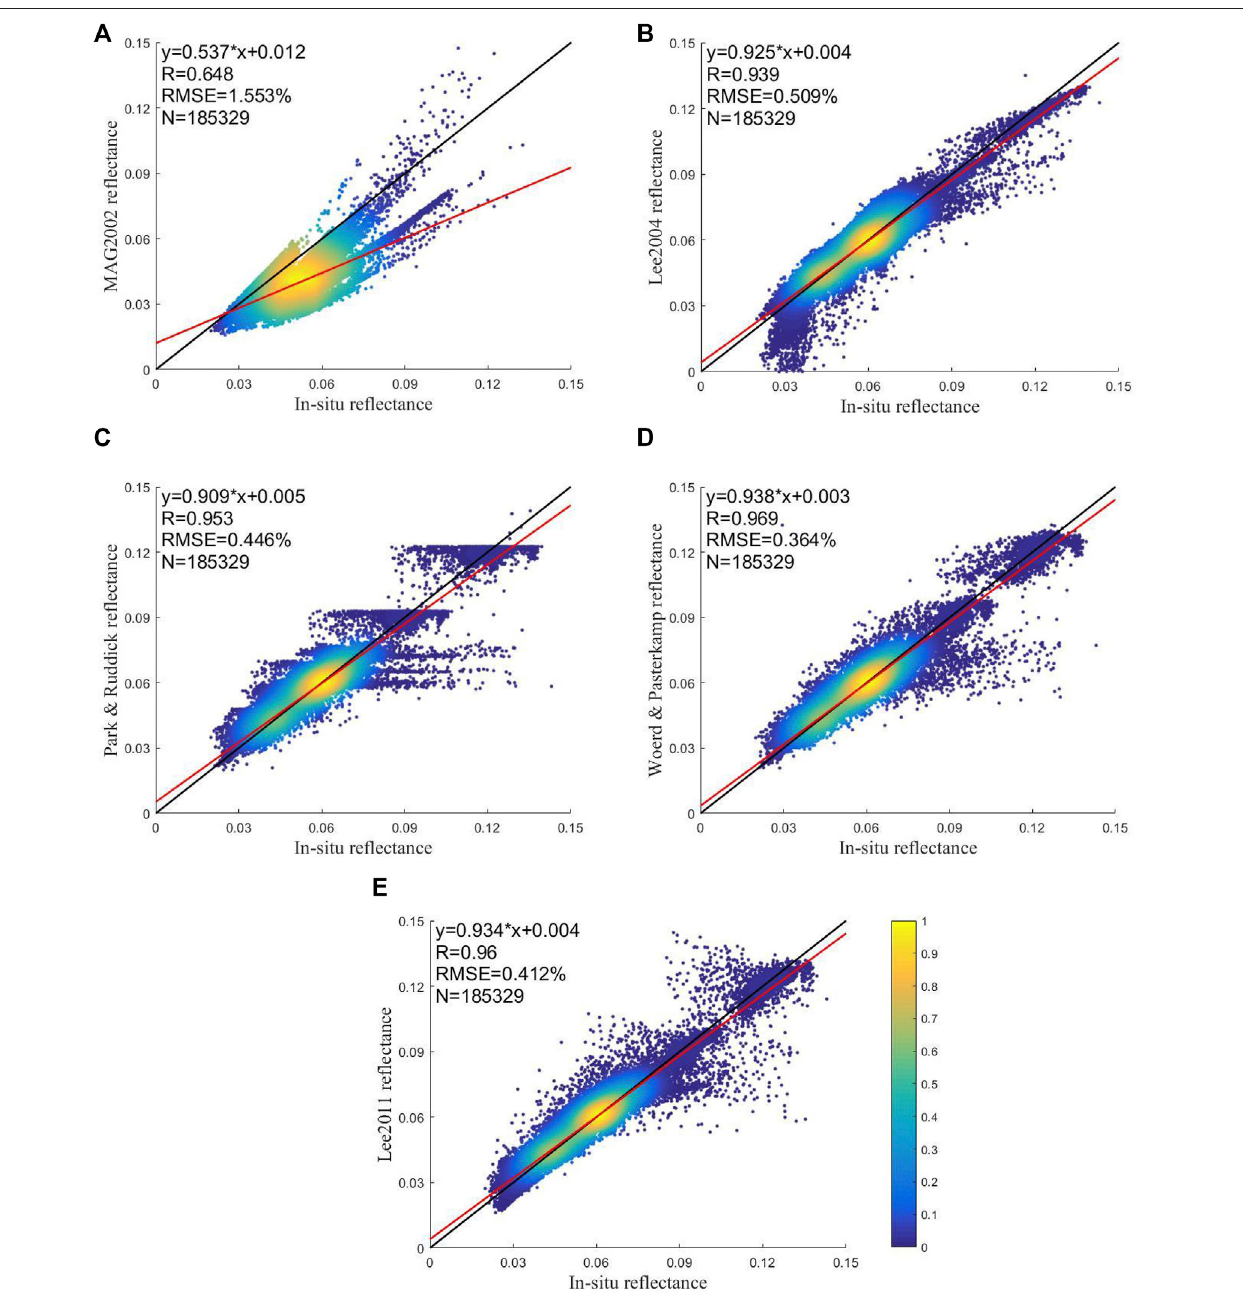
FIGURE 5 | Scatter density plots of model simulations and measurements at the Green Band for Taihu Lake as a whole. The values are presented at linear scales. The solid red color lines in the fi gures are the fi tting lines. The solid black lines are the reference lines of 1:1. The colors indicate the proportional number against the maximumofobservationsonthescale.Thelinear fi ttingformula(y),thecorrelationcoef fi cient(R),theroot-mean-squareerror(RMSE),andthenumberofmeasurements (N) are displayed on the upper left section of each